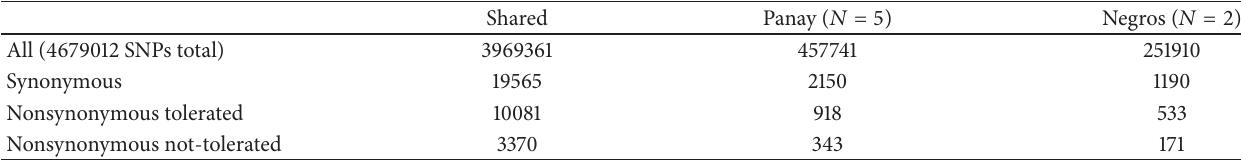
Table 3: Assessment of shared and island-specific variation. The vast majority of the SNPs, both coding and noncoding, are shared between islands, and only a very small portion may be specific. Note that this pertains a total of 4679012 SNPs, excluding fixed differences between S. scrofa and S. cebifrons , for which the minor allele count is at least two out of seven individuals, or 14